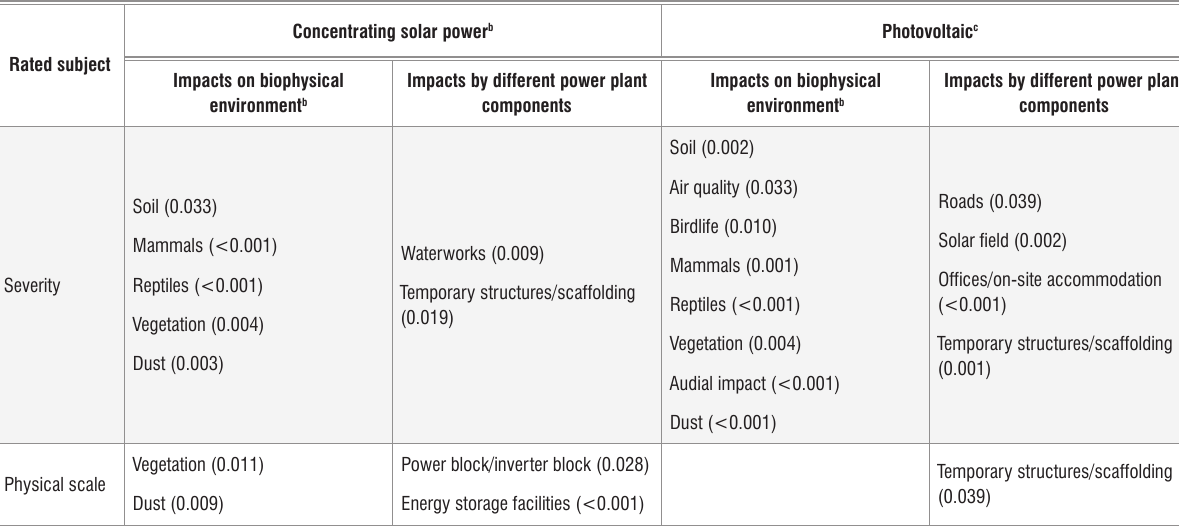
The biophysical components and power plant components for which there was a significant difference in ratings between construction and operation. These are given for severity and physical scale for both concentrating solar power and photovoltaic. Significance ( p -)values are provided in parentheses a